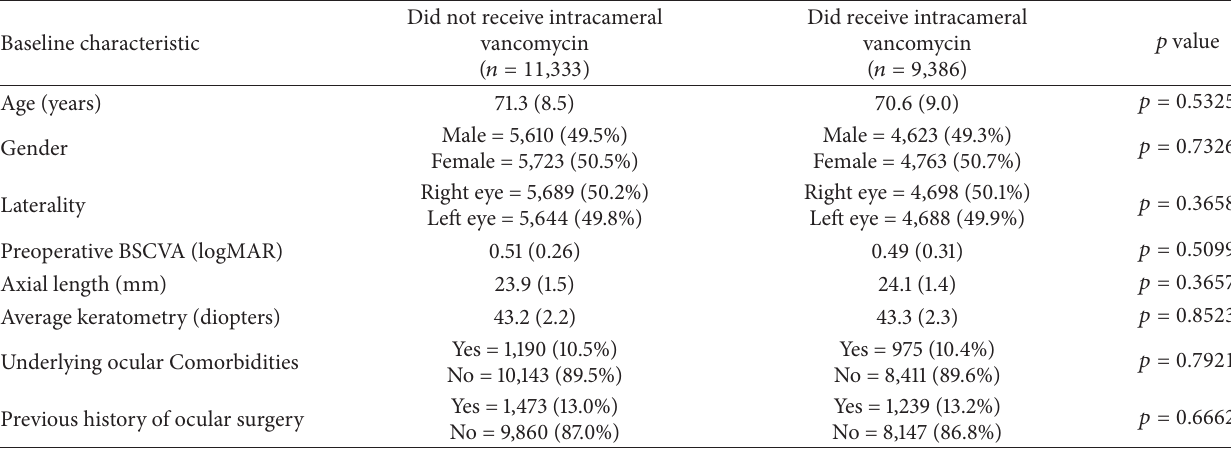
Table 1: The means and distributions with standard deviations of the baseline characteristics among the group that received and the group that did not receive intracameral vancomycin during cataract surgery.